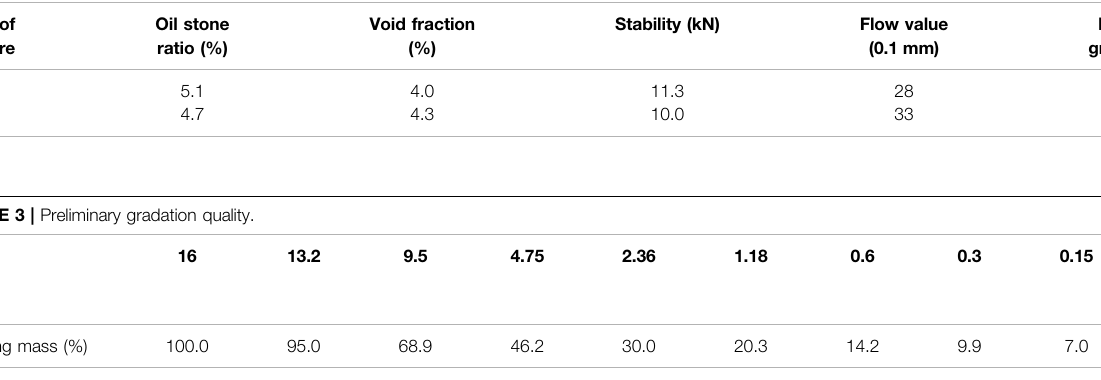
TABLE 2 | Marshall indices of asphalt mixtures.